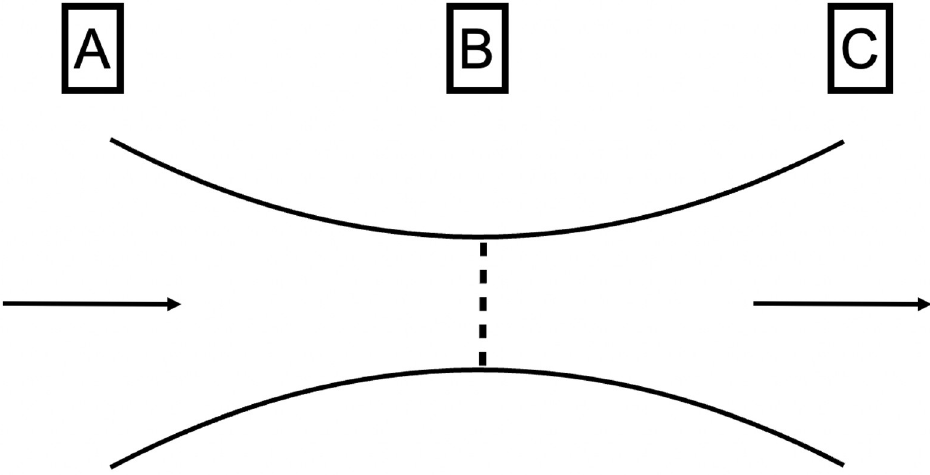
Fig 12. Stenosis image. The arrow points toward the direction of airflow. Notes: A, inlet; B, stenosis; C, outlet.